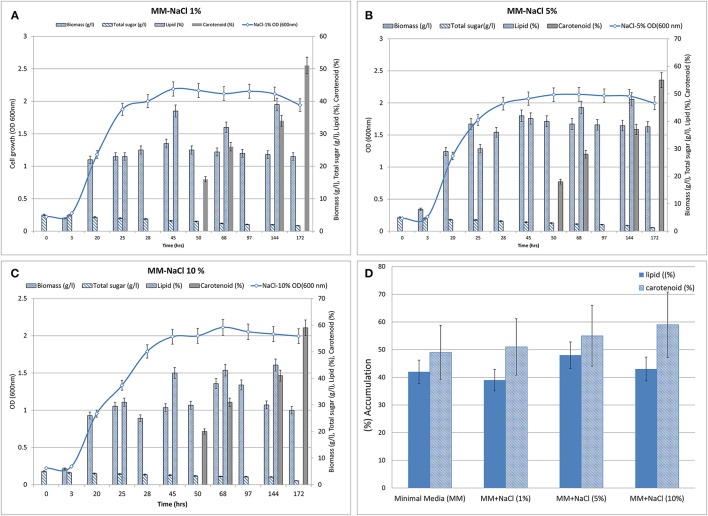
Biomass (growth), total sugar (g/L), lipid (%, w/w) and carotenoid synthesis (%, w/w) profiles of R. toruloides upon treatment. (A) NaCl, 1% (w/v). (B) NaCl, 5% (w/V). (C) NaCl, 10% (w/v). (D) Graph showing maximum lipid and carotenoid biosynthesis in all three treatments (i.e., with NaCl at 1, 5, and 10% w/v).